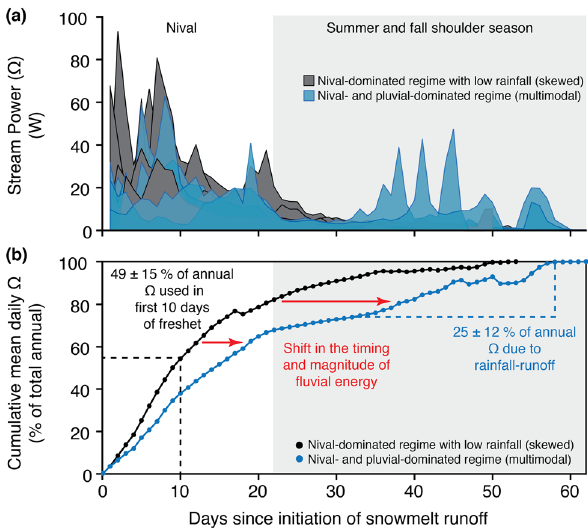
Fig. 1 Hydrological energy budgets for small High Arctic streams. a Daily stream power records for a small, non-glacial High Arctic stream at the CBAWO (West river; 8 km 2 ; 2003 – 2017) normalized to the fi rst day of nival runoff and separated into annual hydrological regimes; (1) nival- dominated regime with little-to-no hydrological response to summer/fall rainfall inputs (skewed distribution; black/gray; n = 8); and (2) nival- and pluvial-dominated hydrological regime (multimodal distribution; blue; n = 4). b Cumulative mean daily stream power (% of the total annual stream power) for the same annual hydrological regimes. In all years, 49 ± 15% of the annual available stream power is expended in the fi rst ten days of freshet and 74 ± 13 % is expended during the full nival period (22 ± 5 days). In warmer wetter years with proportionately more pluvial discharge (blue) we observe a transition in the timing and magnitude of fl uvial energy to later in the summer thaw season. In these years, pluvial runoff expended 25 ± 12% of the annual stream power budget during the summer and fall shoulder seasons. Base fl ow periods had the lowest stream powers expending <5% of the annual stream power budget.